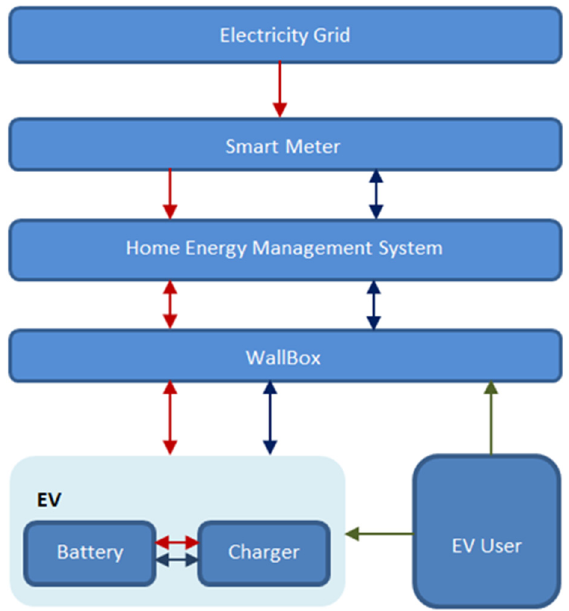
Figure 1. Vehicle-to-home (V2H) charging scheme.